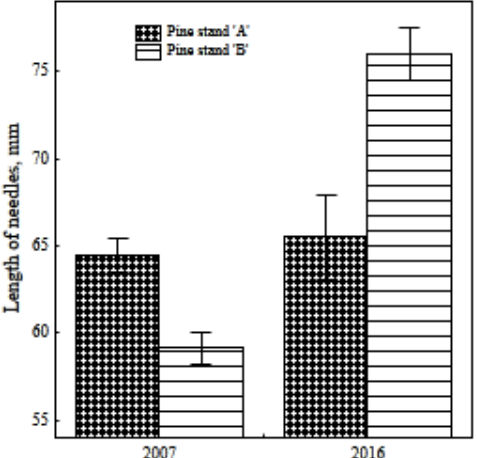
Figure 6. The length of 2-year pine needles sampled in 2007 and 2016 from upper parts of pine crowns. The average values for 120–200 needles sampled from 8–9 trees and their standard errors are presented. The length of the needles in pine stands ‘A’ and ‘B’ was significantly different in both 2007 and 2016 ( p < 0.05).